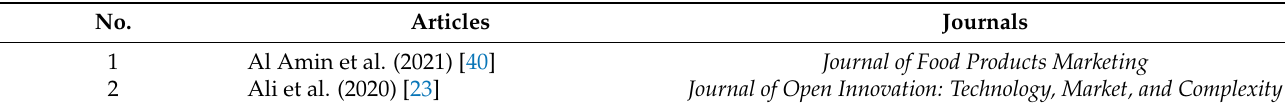
Table A1. A list of articles included in the